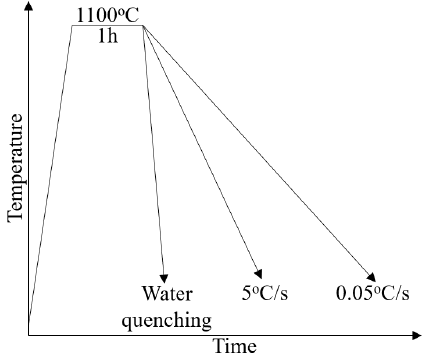
Figure 1. Heat treatment cycles applied to the specimens.